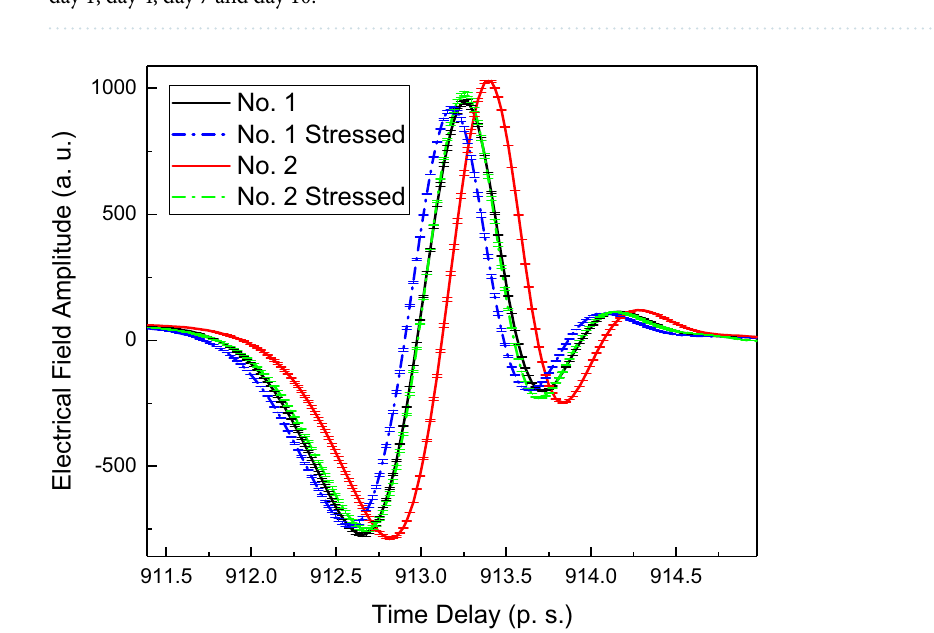
Figure 4. THz time domain spectra collected on the surface of corneas with the indication of data error